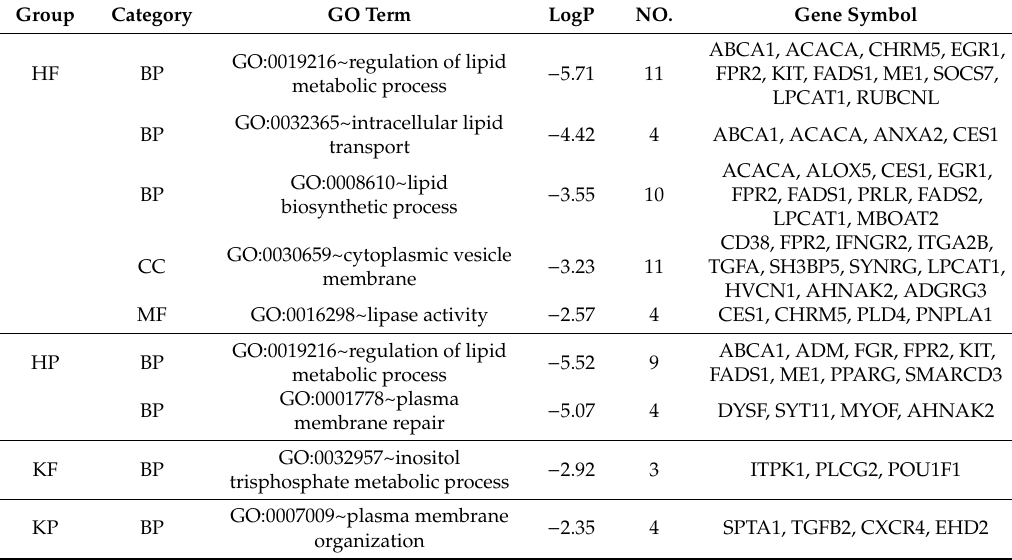
Table 1. GO terms of lipid metabolisms in KG1a and HL60 exposed to FeNPs or PBNPs (Top 20, p < 0.01).